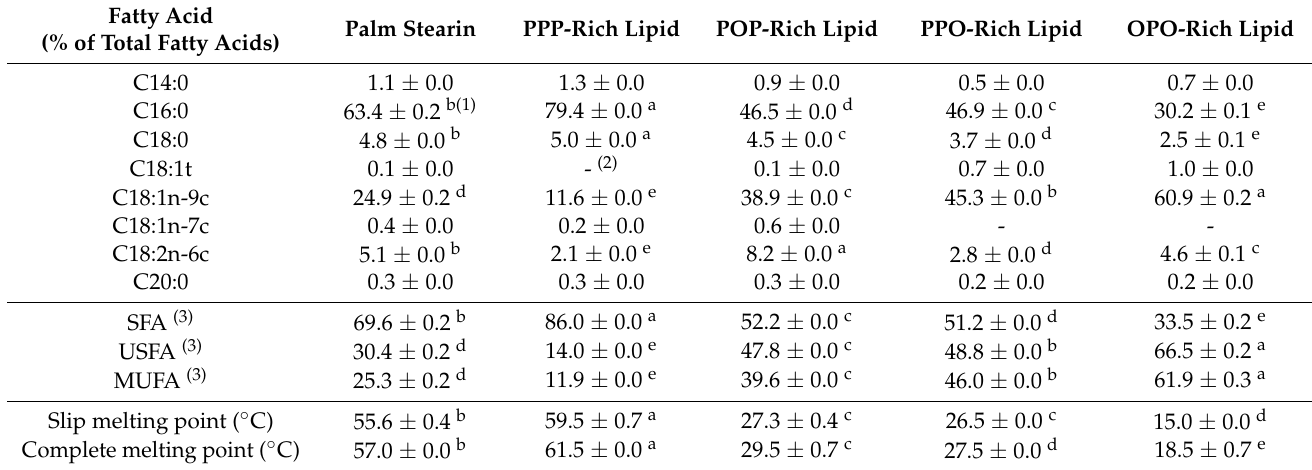
Figure 1. Production scheme of PPP-rich and POP-rich lipids ( A ), PPO-rich, and OPO-rich lipids ( B ). Table 2. Total fatty acids composition and melting points of the